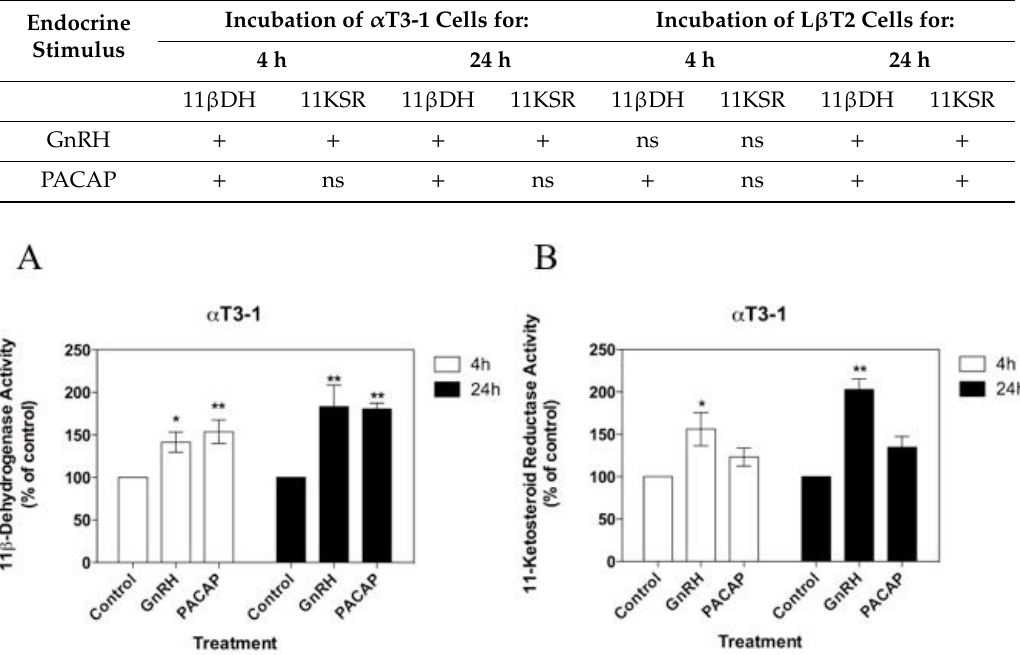
Figure 4. Effects of GnRH and PACAP on ( A ) 11β -dehydrogenase and ( B ) 11-ketosteroid reductase activities in LβT2 cells over 4 h and 24 h using 100 nM [ 3 H]-cortisol and 100 nM [ 3 H]-cortisone as enzyme substrates. Values are mean ± SEM for three different cell passages (with triplicate measures